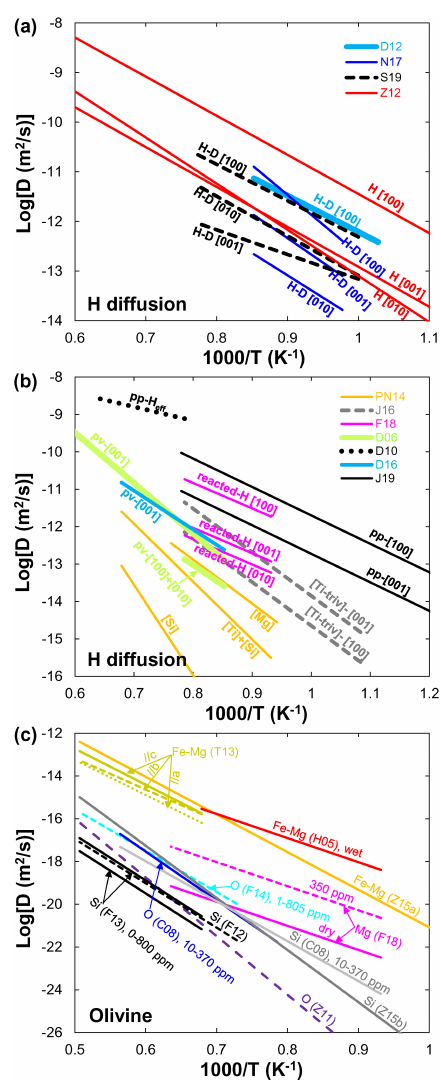
Figure 1. (a) Arrhenius plot summarizing experimental results for hydrogen diffusion in olivine. Data sources: Z12 (Zhang, 2012); D10 (Demouchy, 2010); D06 (Demouchy and Mackwell, 2006); D12 (Du Frane and Tyburczy, 2012); N17 (Novella et al., 2017); D16 (Demouchy et al., 2016); J16 (Jollands et al., 2016); S19 (Sun et al., 2019). (b) Arrhenius plot summarizing experimental results for dehydration experiments in olivine. Data sources: D06 (Demouchy and Mackwell, 2006); D10 (Demouchy, 2010); PN14 (Padrón-Navarta et al., 2014); D16 (Demouchy et al., 2016); J16 (Jollands et al., 2016); F18 (Ferriss et al., 2018); J19 (Jollands et al., 2019). Note that pv and pp stand for proton–metal vacancy and proton–polaron exchange mechanism, respectively. (c) Arrhe- nius plot summarizing experimental results for other elements’ (Li, He, Mg, Fe–Mg, O, Si) diffusion in olivine under dry and hydrous conditions. Data sources: C12 (Cherniak and Watson, 2012); DK10 (Dohmen et al., 2010); T13 (Tachibana et al., 2013); H05 (Hier- Majumder et al., 2005); C08 (Costa and Chakraborty, 2008); F12 (Fei et al., 2012); F13 (Fei et al., 2013); F14 (Fei et al., 2014); F18 (Fei et al., 2018); Z11 (Zhang et al., 2011); Z15a (Zhang and Shan, 2015a); Z15b (Zhang and Shan,